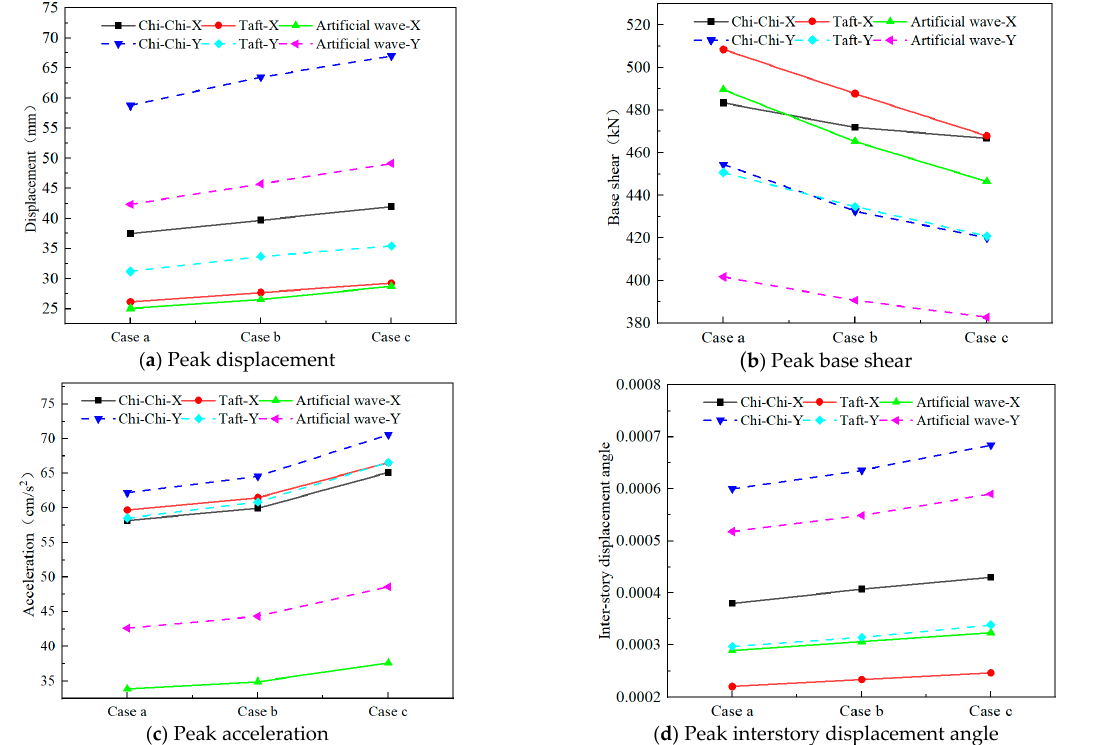
Figure 6. Results of frequent-earthquake time-history analysis.